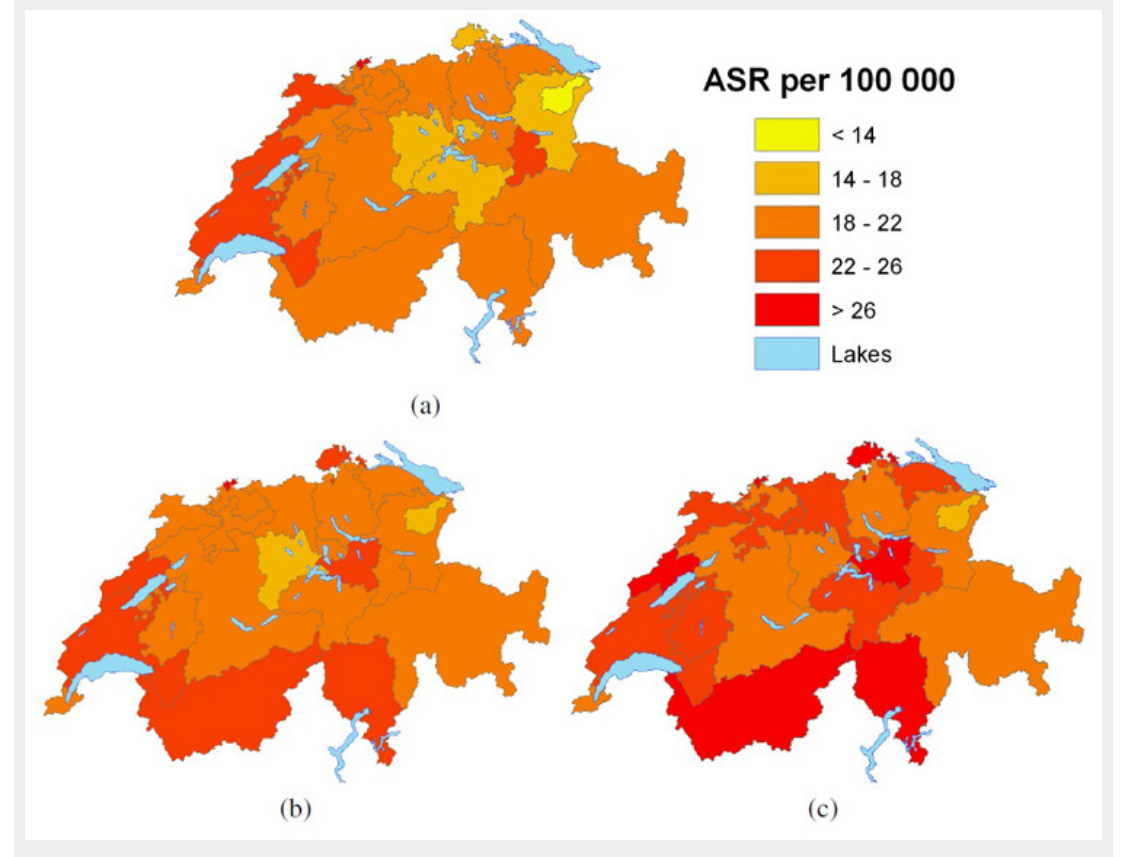
Figure 7 Age-standardised tobacco-related cancer mortality rates (per 100,000) for females age ≥50years, (a) observed during 2004–2008 and predicted posterior median (b) during 2009–2013 and (c)